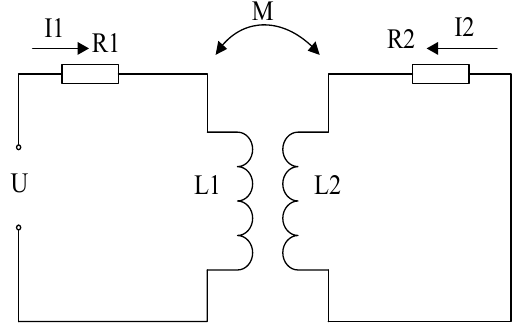
Figure 1. The equivalent circuit of the PEC testing system.